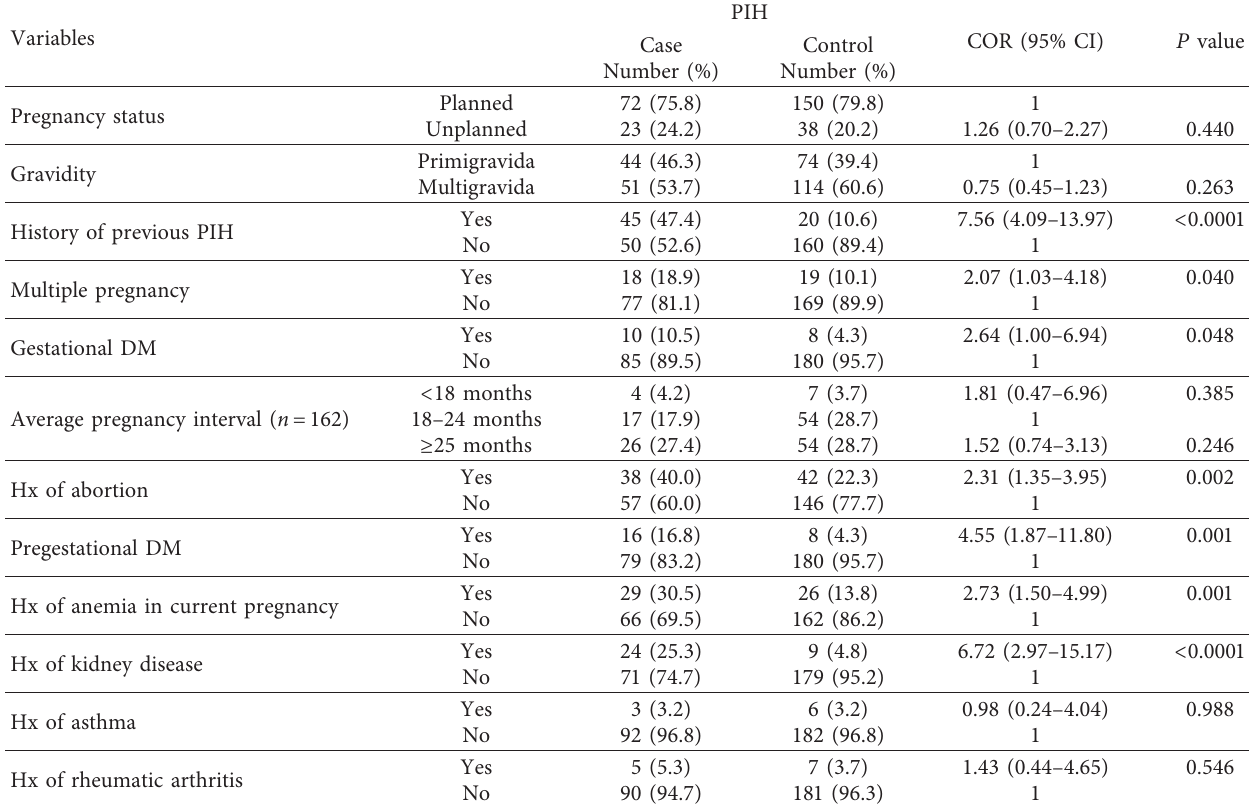
Table 4: Obstetrics and medical characteristics of mothers with/without hypertensive disorders of pregnancy in Wolaita zone, southern Ethiopia,